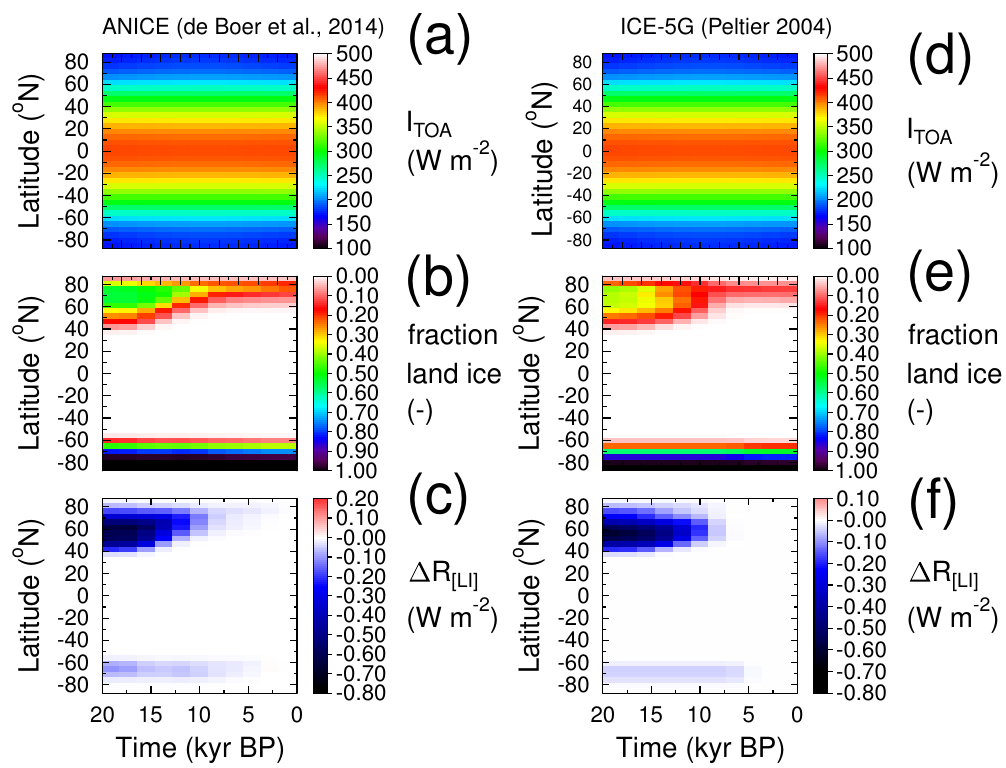
Figure 5. Comparing the calculation of radiative forcing of land ice sheets for the last 20kyr for two different ice-sheet set-ups. Left: the 3-D ice-sheet model ANICE used in this study (de Boer et al., 2014); right: calculation based on 1 ◦ × 1 ◦ model output from ICE-5G (Peltier, 2004), results for radiative forcing of land ice sheets, (cid:49)R [LI] , then based on similar aggregation to latitudinal bands of 5 ◦ as for ANICE. Panels (a,d) : annual mean insolation at the top of the atmosphere, I TOA , based on orbital variations (Laskar et al., 2004). Panels (b,e) : fraction of each latitudinal bands of 5 ◦ covered by land ice as simulated by the 3-D ice-sheet models. Panels (c,f) : calculated radiative forcing of land ice sheets, (cid:49)R [LI] , normalized to global-scale